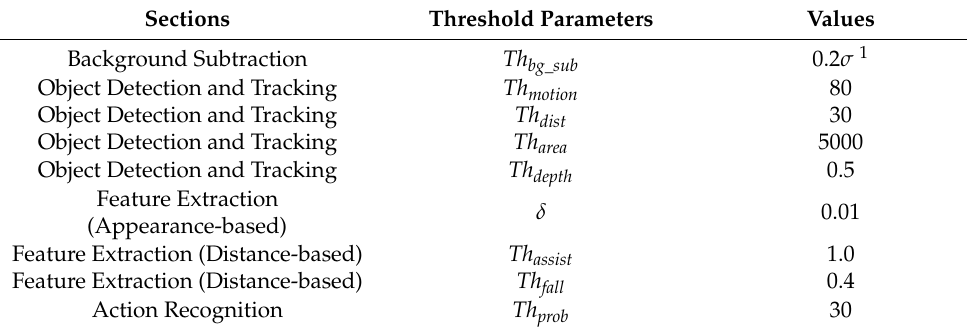
Table 2. Threshold parameter values used throughout the process.